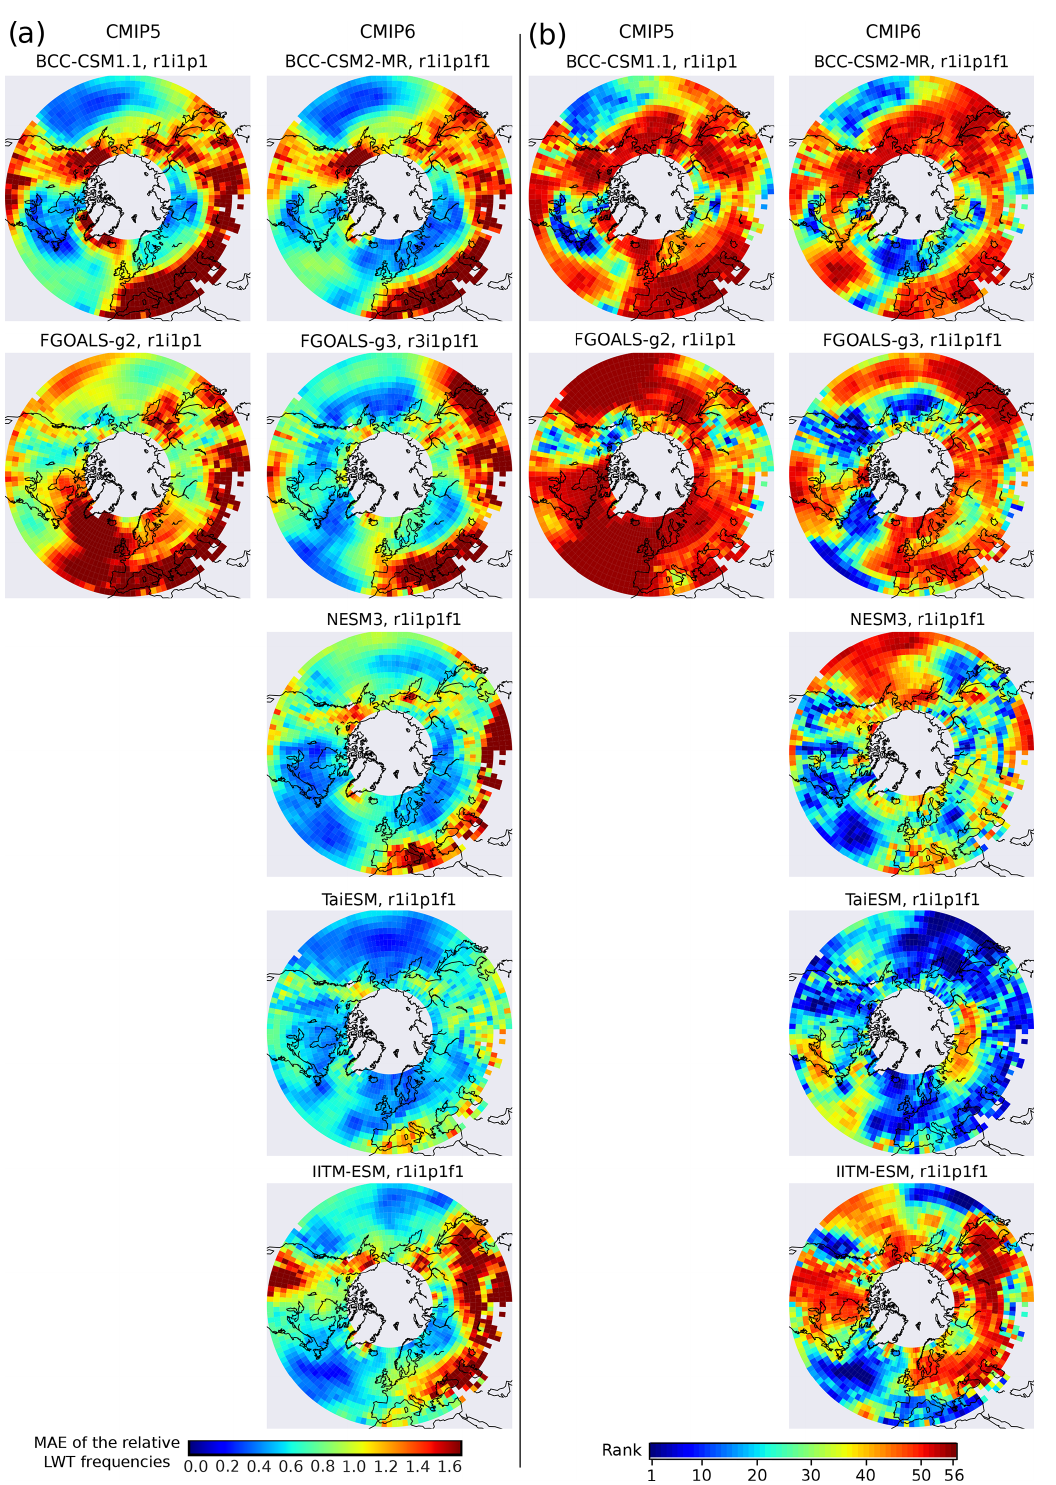
Figure 6. As Fig. 3 but for the BCCR and FGOALS models, as well as for NESM3, TaiESM and IITM-ESM.